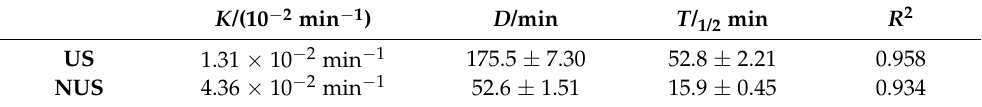
Figure 2. Inactivation curves of US and NUS treated PPO. US stands for ultrasonic treatment, NUS stands for ultrasonic treatment combined nisin treatment, which showed that the degree of PPO denaturation increased with increasing sterilization time. Table 1. Values of k , D , and T 1/2 of PPO inactivation in chestnut lily beverages treated with US and